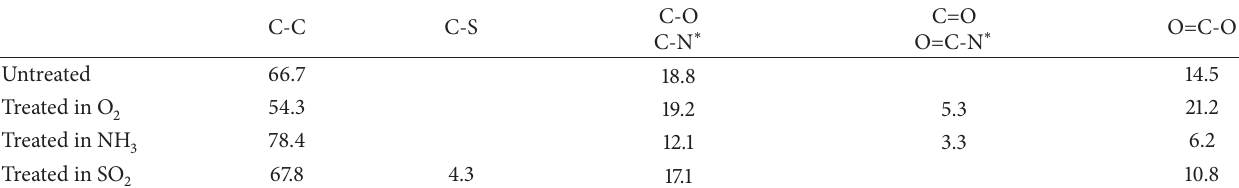
Table 2: Concentration of different functional groups for various plasma treated samples ( ∗ in the case of NH 3